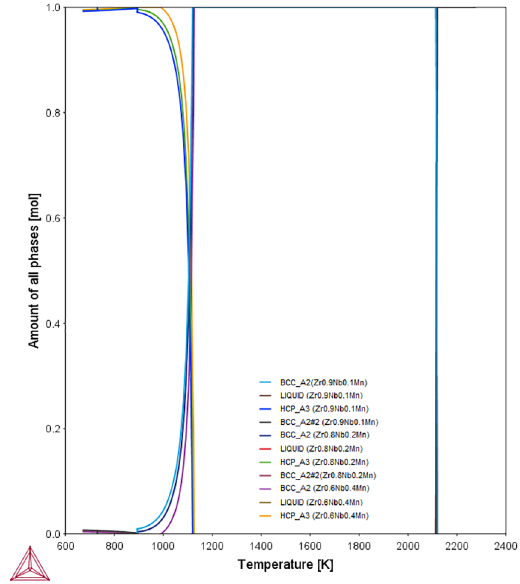
Figure 2. Simulation of cooling curves of Zr-0.9Nb-0.1Mn, Zr-0.8Nb-0.2Mn and Zr-0.6Nb-0.4Mn.